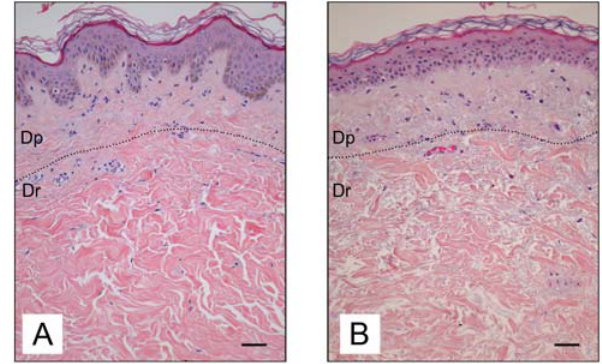
Figure 2. Histological characteristics of young and old human skin. Photographs shown correspond to histological sections of mammary skin biopsies obtained from a 19 year old (A) and a 74 year old donor (B). Sections were stained with hematoxylin, eosin, and saffron (HES). Scale bars=50 m m. Dp=papillary dermis. Dr=reticular dermis.